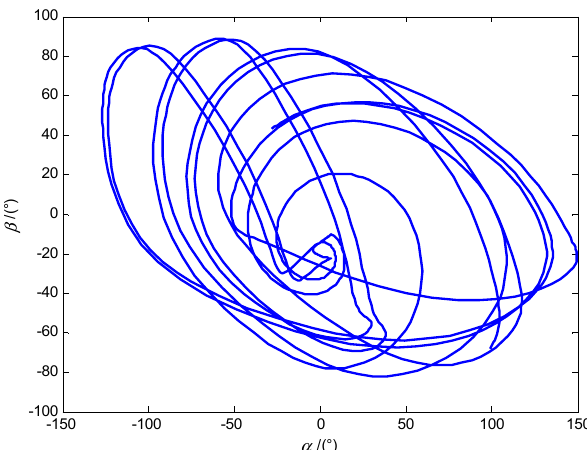
Figure 14. The system phase diagram of the DSCR for the chaotic motion.